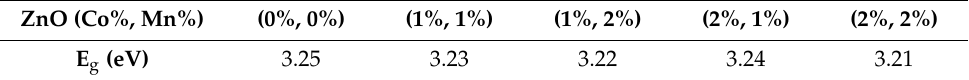
Table 5. Band gap energy (E g ) values of the undoped and (Co, Mn) co-doped ZnO.